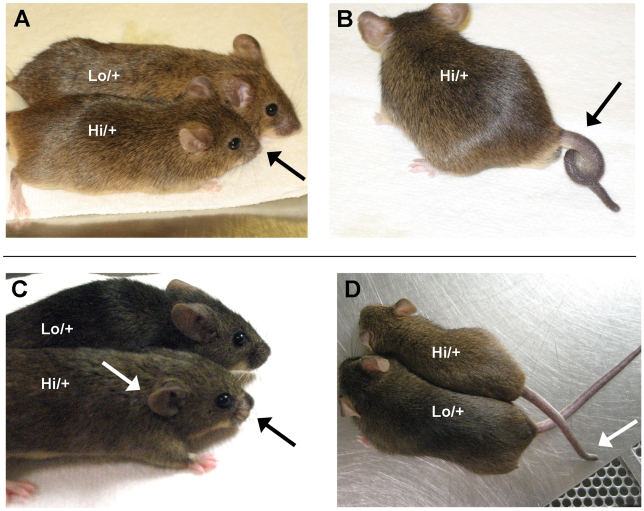
Survivors of Ctgf Hi/+ embryonic lethality.Gross morphology of high Ctgf-expressing survivors at 10 months old. Males are shown in A) and B) and females are shown in C) and D). In A) and B) the Ctgf Hi/+ mice (foreground) have small ears, shortened face and short body length. B) The short curly tail of the Hi/+ male. D) Short kinked tail and short body of the Hi/+ female (top) compared with a control sibling (bottom). All the animals shown are siblings from a cross between Ctgf Lo/+ and EIIa-Cre +/− animals on a mixed B6.129 background. The controls (background of A) and C) and bottom of D)) are of the genotype Ctgf Lo/+.